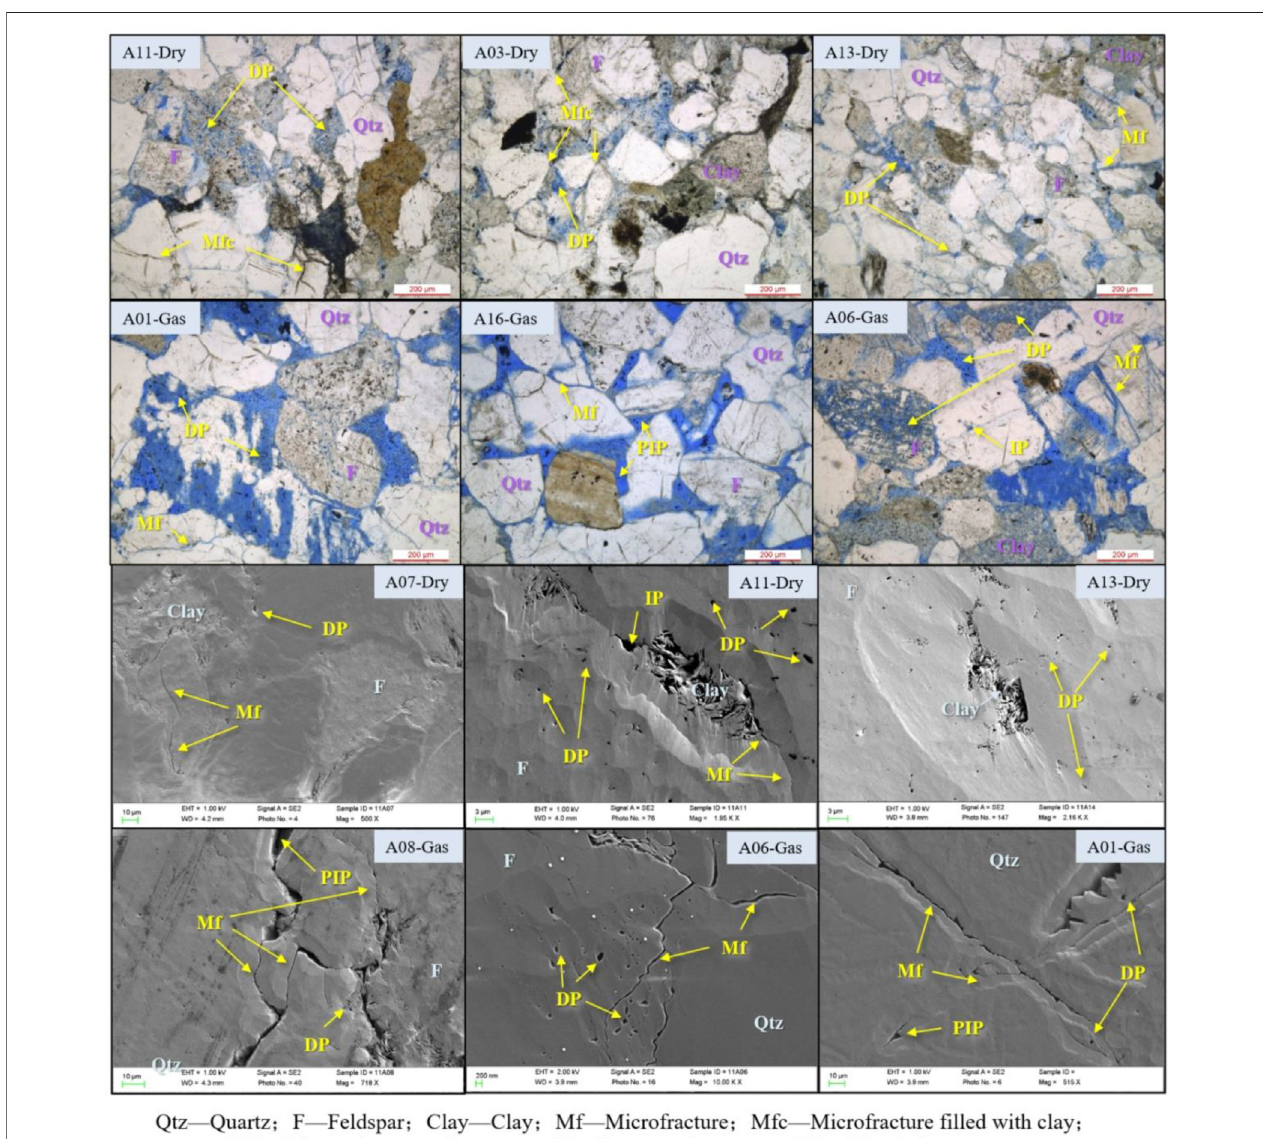
FIGURE 5 | Casting thin section images and SEM images, demonstrating the pore structure difference between gas-bearing and dry formations.